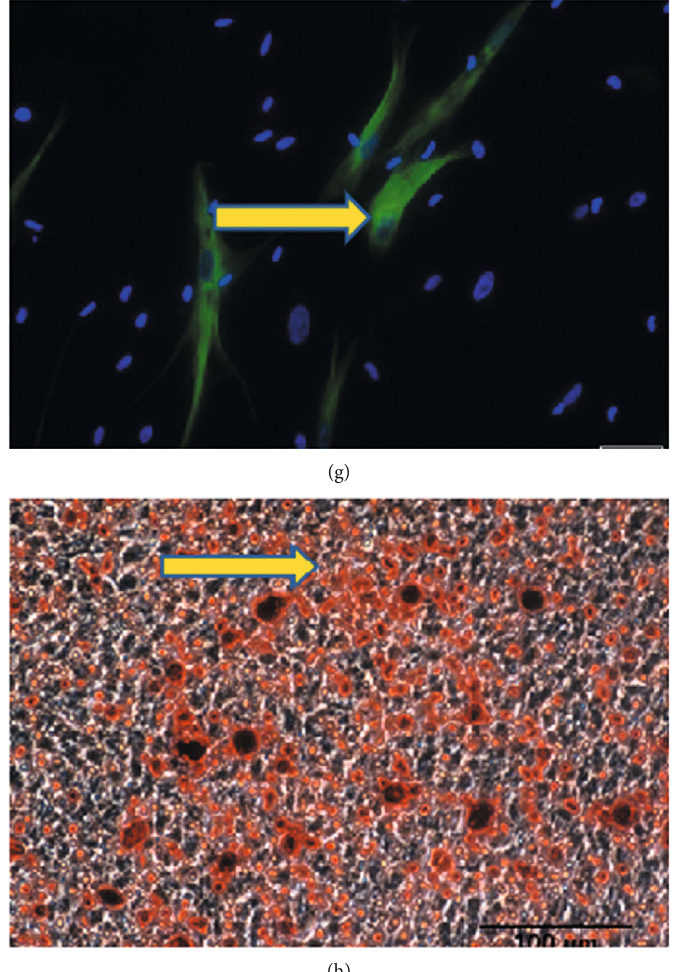
Figure 1: Characterization of stem cells isolated from human exfoliated deciduous teeth (SHED). Results of fl ow cytometric analyses of SHED are shown. (a) Isotype-matched IgG1 antibody was used as a control. Percentages of cell markers CD73 (b), CD105 (c), CD34 (d), and CD45 (e) expressed in SHED were analyzed by fl ow cytometry. (f) Morphologically, the cultured SHED were spindle-shaped. (g) Expression of the neural marker β III-tubulin in SHED after 4 weeks of neural inductive culture. (h) SHED formed Alizarin Red S-positive mineralized nodules after 4 weeks of induction of osteogenic di ff erentiation. Scale bar = 20 μ m (g), scale bar = 100 μ m (f,